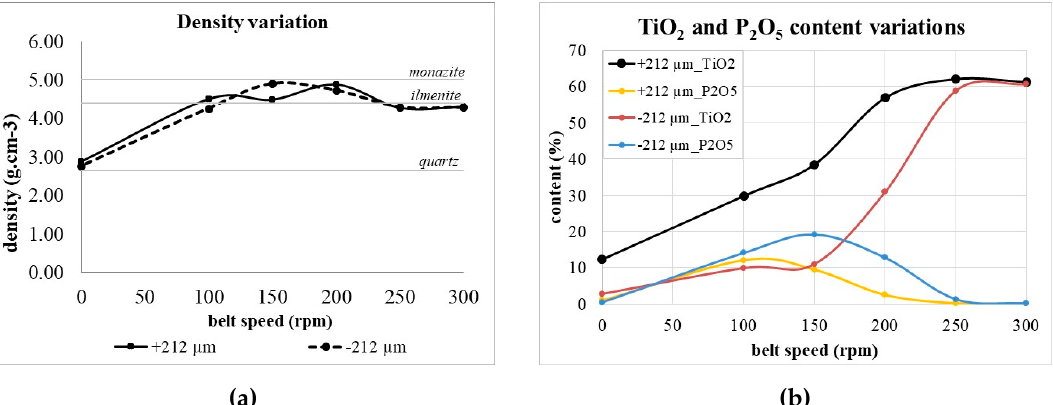
Figure 11. Density variations of the material recovered in different belt speeds ( a ), and variation of selected oxide (TiO 2 and P 2 O 5 ) contents for +212 µ m and − 212 µ m size fractions according to the magnetic separator’s belt speeds ( b ).